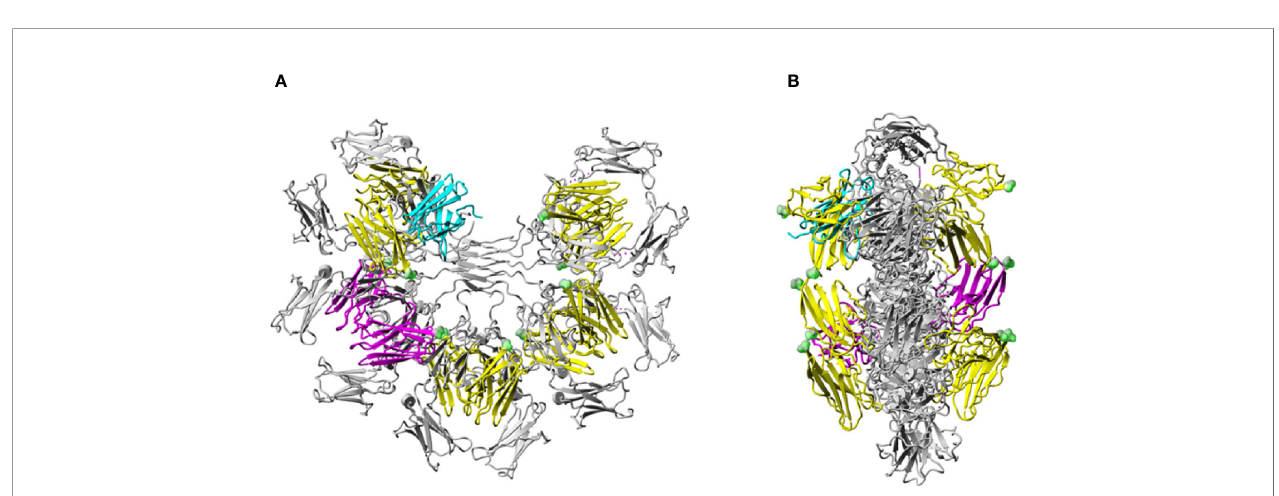
FIGURE 6 | Model of the human FcµR/IgM interaction. Model of human FcµR Ig-like domains in complex with pentameric IgM-Fc (A) and rotated by 90° (B) . Pentameric IgM-Fc [PDB 6KXS, without J-chain or secretory component (SC)] (25) is shown in grey. The two FcµR domains docked onto heavy chains C and D of IgM-Fc are colored in magenta. Four other pairs of FcµR Ig-like domains located similarly on the four other Fc subunits of the IgM pentamer are colored in yellow. The location of the pIgR D1 (SC) (25) is shown in cyan. The C-termini of each of the 10 FcµR domains are indicated by green